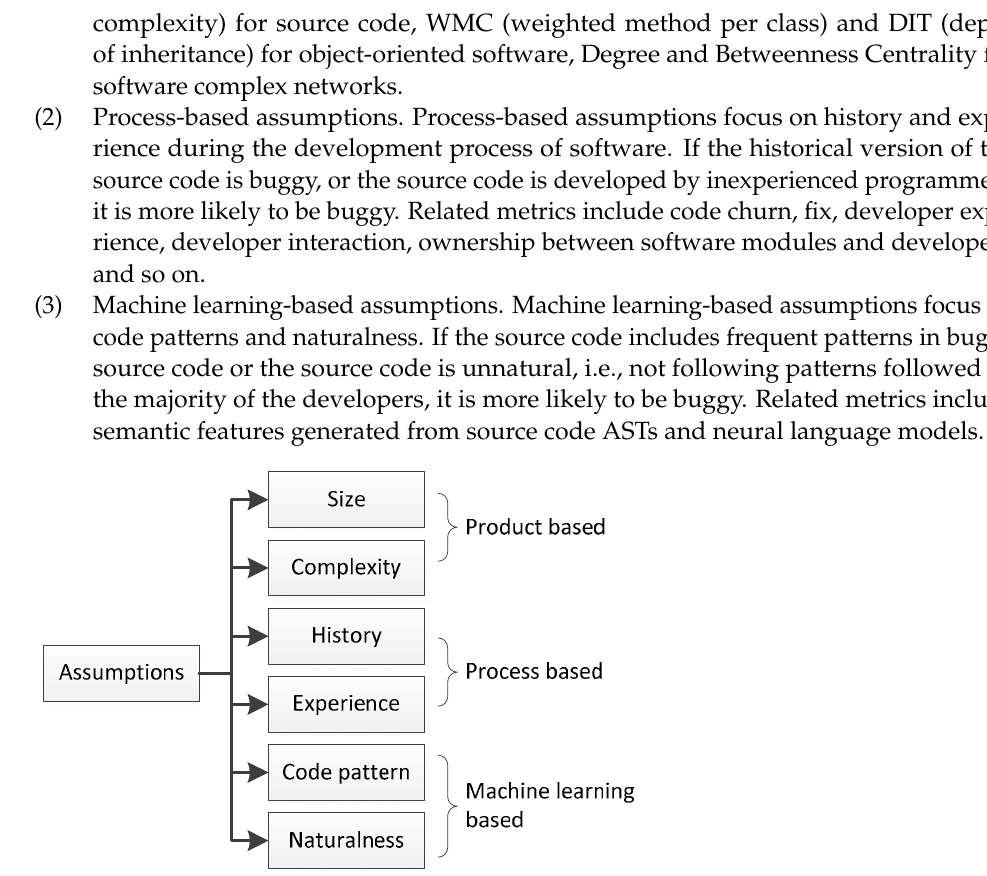
Figure 8. Assumptions that influence software defect prediction.